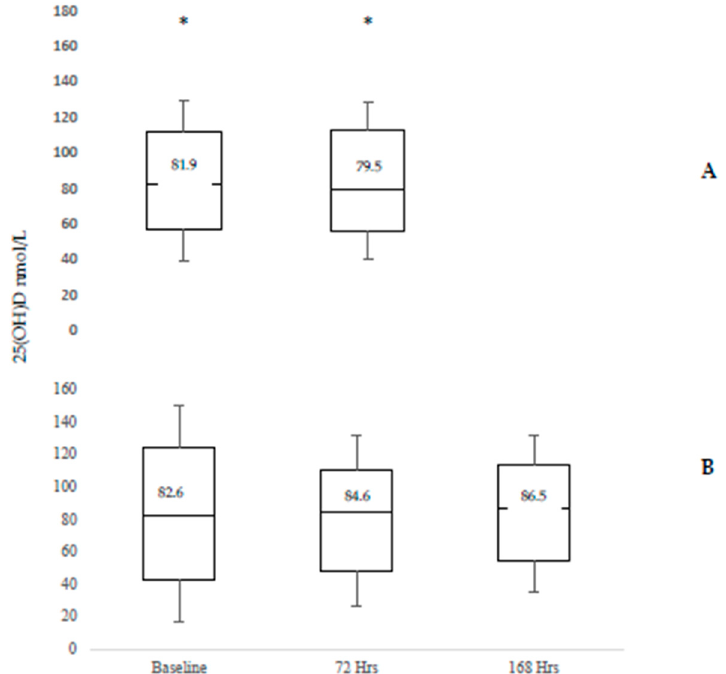
Figure 2. 25(OH)D Concentration at baseline, 72 h and 168 h post exposure to natural sunlight for a total of 30 min in the Younger (Panel A) and Older (Panel B) Adult Cohorts. * represents single data points that were greater than three times the interquartile range.